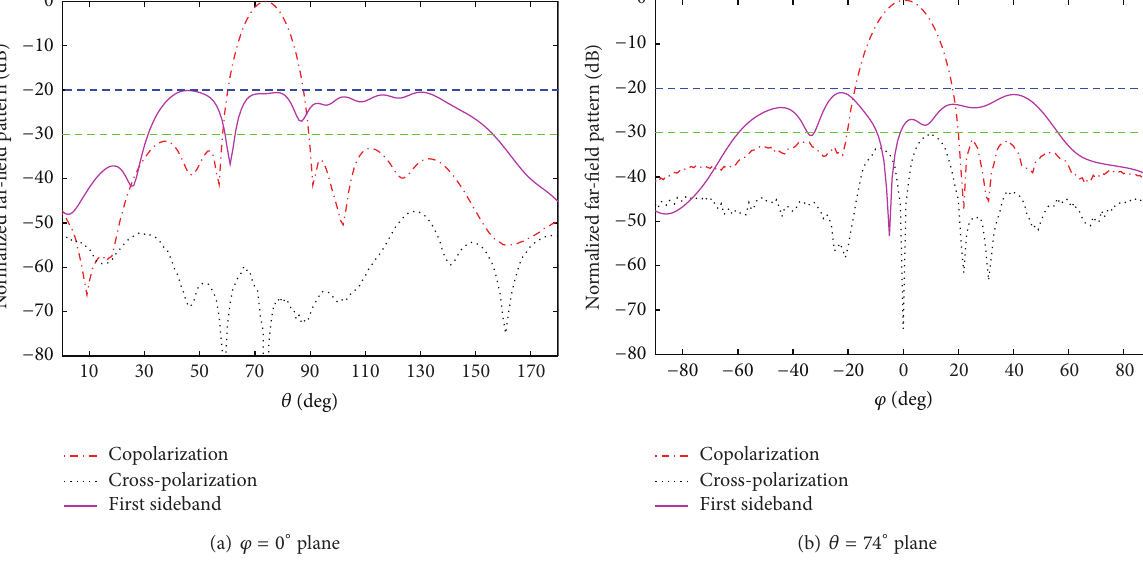
⃗ V = ( V , V , . . . , V ) . Each particle keeps track of its own 𝑖 𝑖1 𝑖2 𝑖𝐷 best position 𝑝 best 𝑖 = (𝑝 best 𝑖1 , 𝑝 best 𝑖2 , . . . , 𝑝 best 𝑖𝐷 ) and the best position among all the particles obtained so far in the population 𝑔 best = (𝑔 best 1 , 𝑔 best 2 , . . . , 𝑔 best 𝐷 ) , which are given